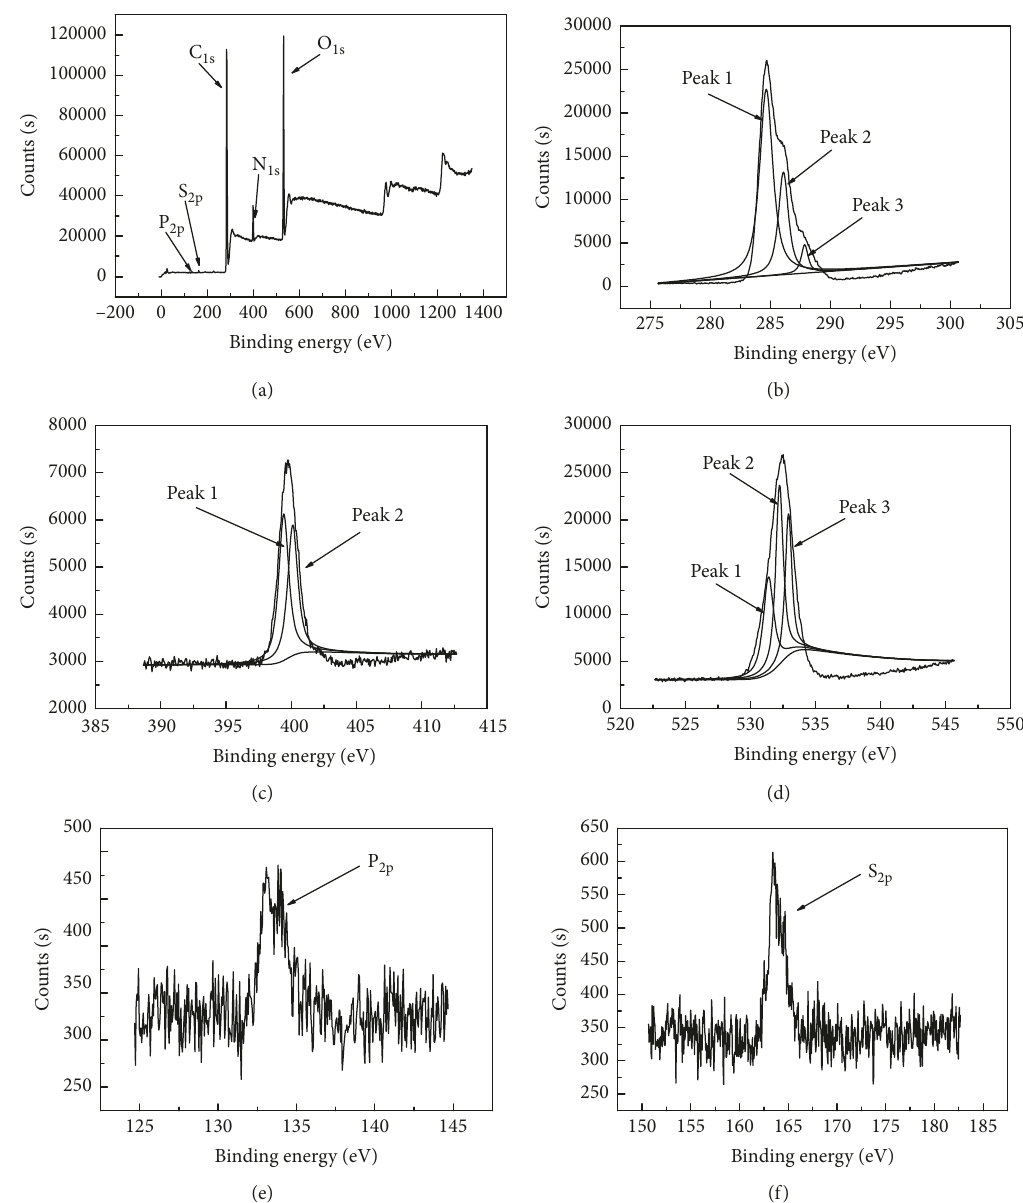
Figure 4: XPS spectrum of flour particles (#8) with survey scans (a) and decomposition of C